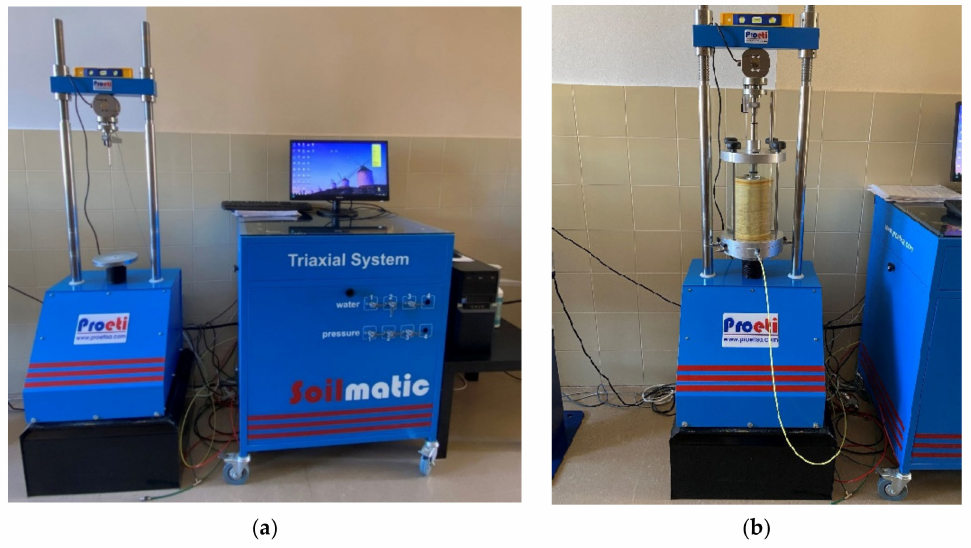
Figure 3. The triaxial test device and multiuse press used. ( a ) Complete apparatus; ( b ) Detail showing the use of the device’s 101.6 mm specimen vessel during an